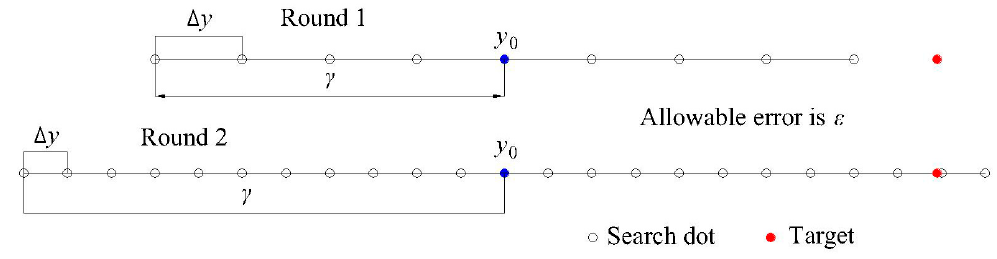
Figure 12. Logical meshing of the DFM.